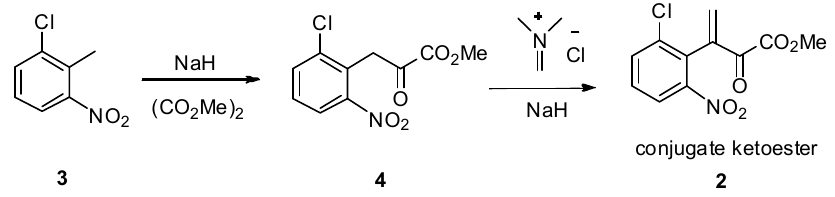
Scheme 1. Synthesis of conjugate ketoester 2 .